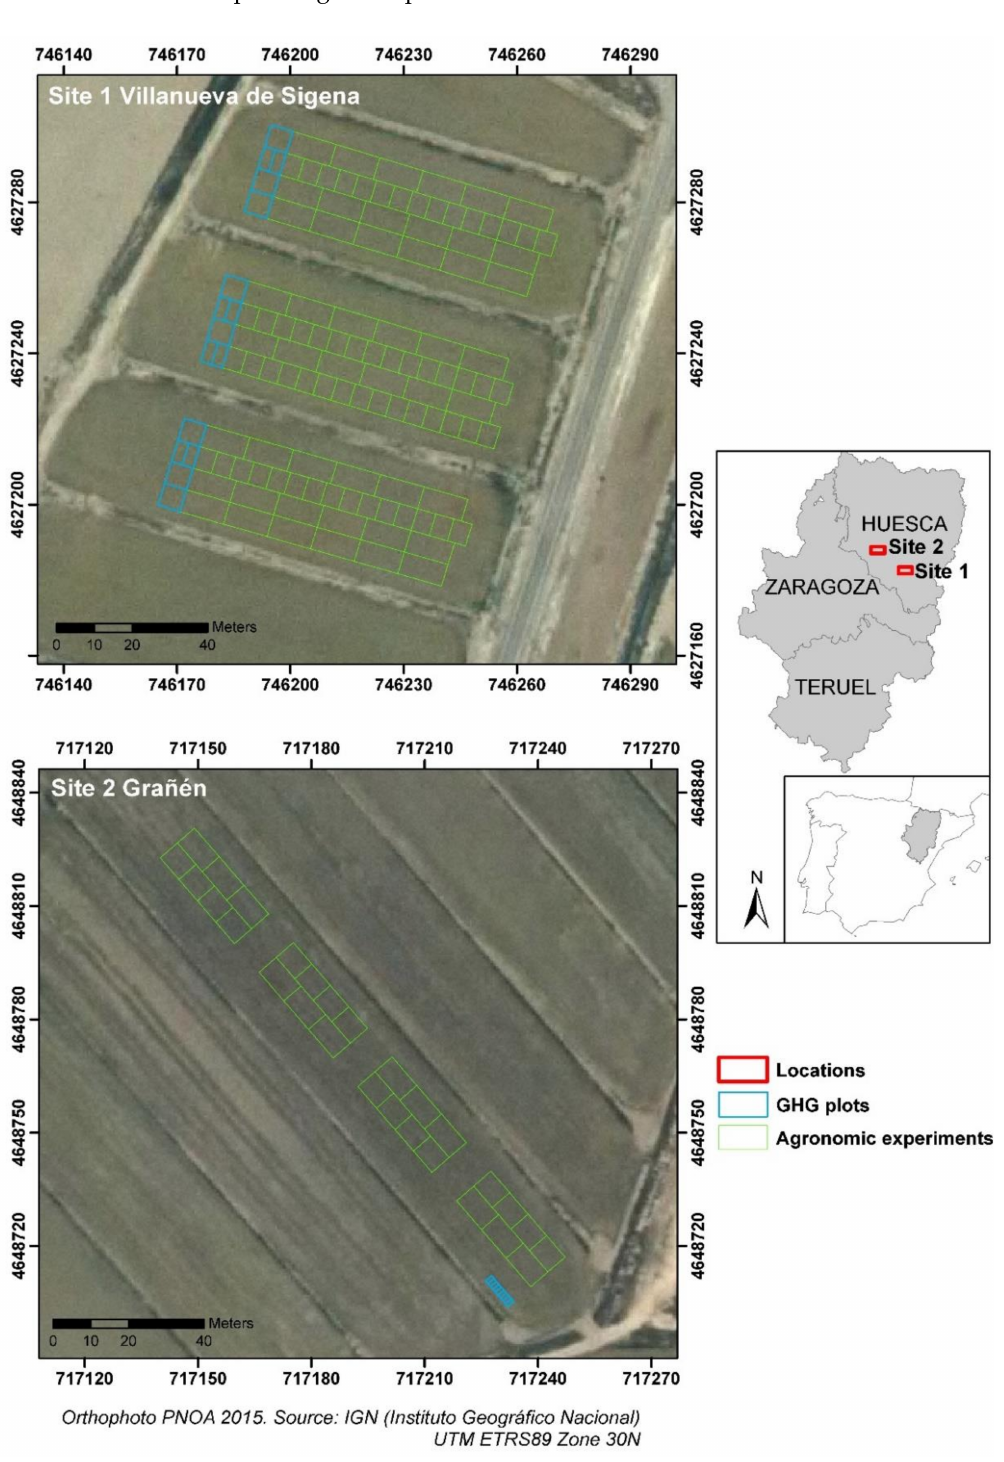
Figure 1. Locations and experimental designs of the two experiments at Villanueva de Sigena and Grañ é